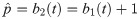
Order routing policy.A new buy limit order at price p^=b2(t)=b1(t)+1 arrives and is routed to market 1 since it will have better priority at that price, i.e. d1b(p^,t)<d2b(p^,t). In market 1, a new limit order to buy at p^ is first in the queue with no depth ahead toward the best ask. In market 2, the same order is third in the queue. A new market order to sell is routed to market 2 since b2(t)>b1(t).